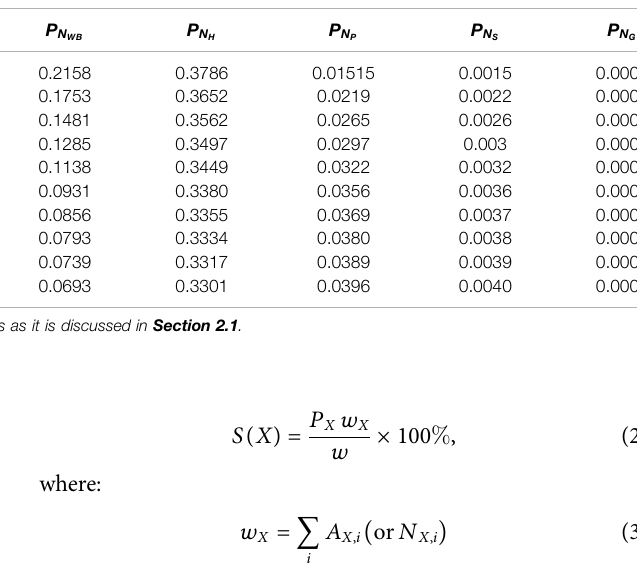
TABLE 1 | Weight parameters considered for the data from year